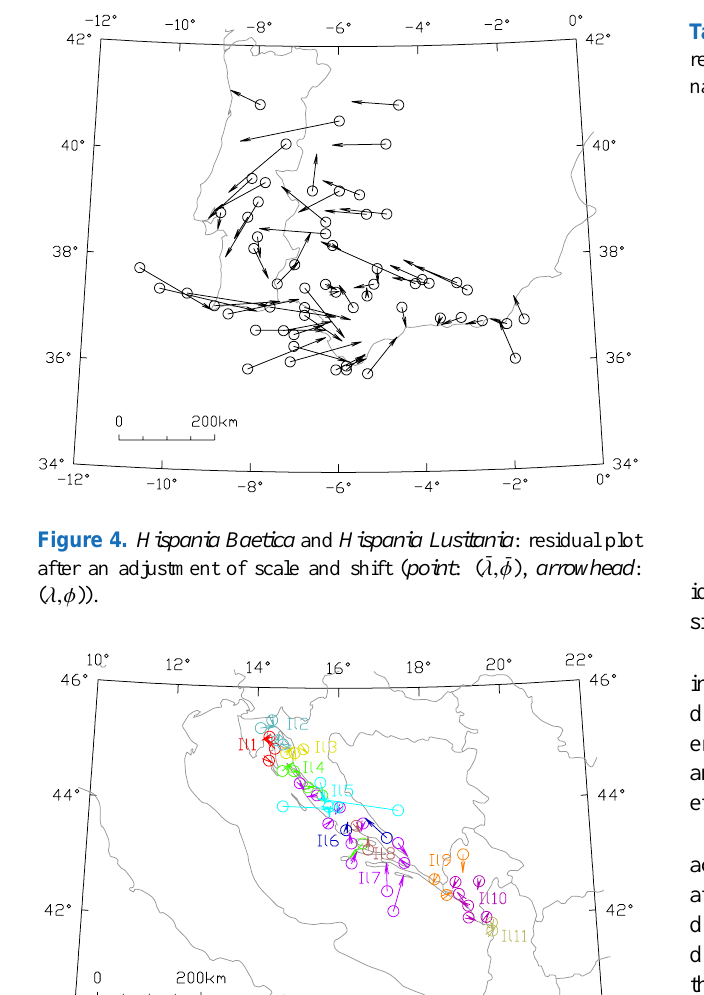
Coordinate values which cannot be explained by system- atic scalings and shifts are regarded as grossly erroneous.